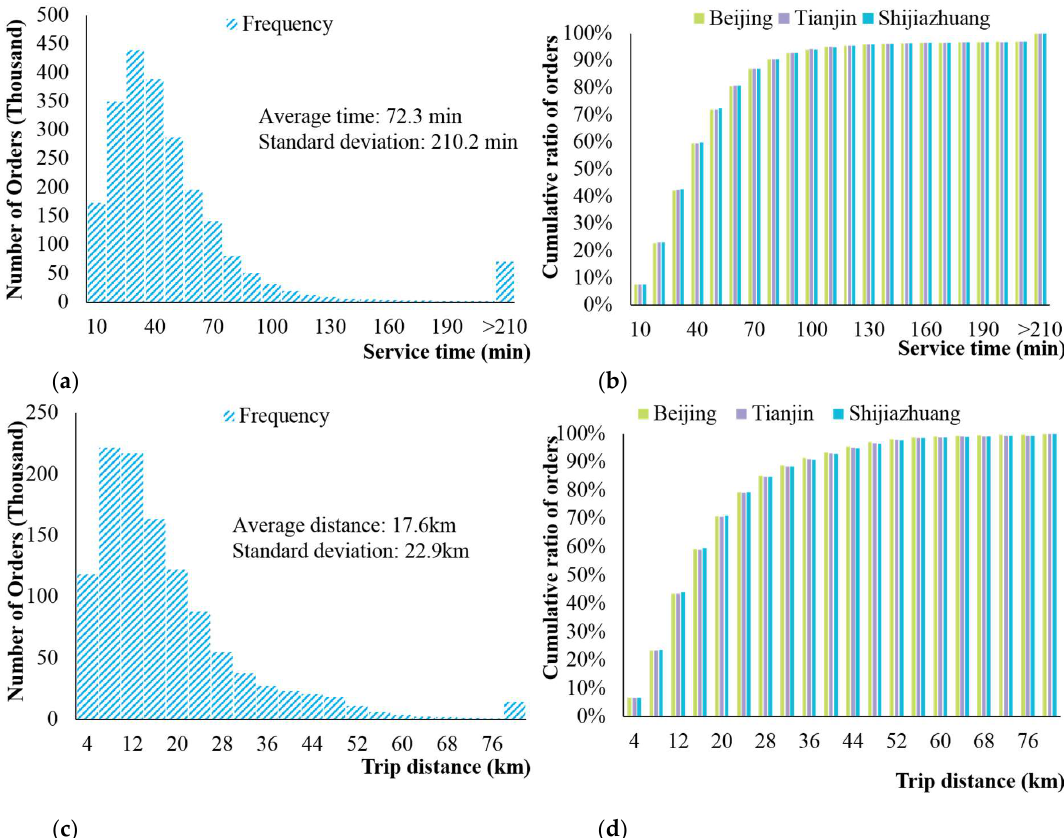
Figure 5. Service time and trip distance of ridesharing. Multiple panels: ( a ) Distribution of ridesharing service time in BTH region; ( b ) Distribution of ridesharing service time; ( c ) Distribution of ridesharing trip distance in BTH region; ( d ) Distribution of ridesharing trip distance.